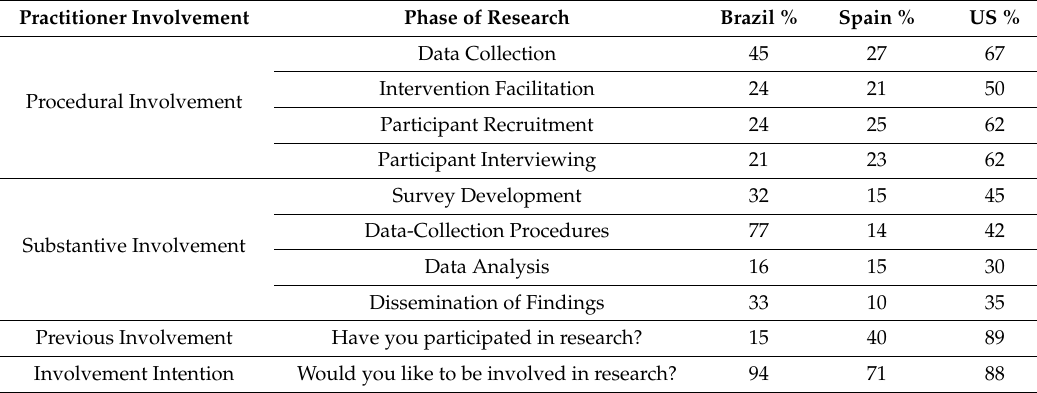
Table 2. Practitioner involvement in social and health research in different